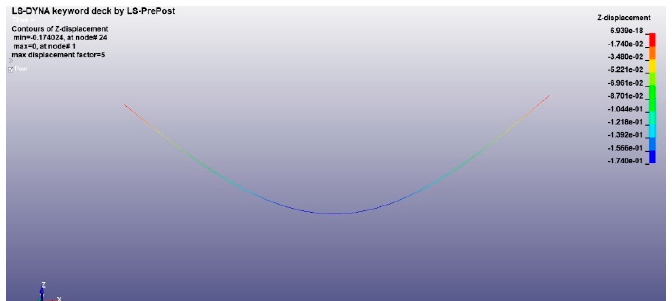
Figure 13. Finite element simulation model of a simply supported FFU composite beam.